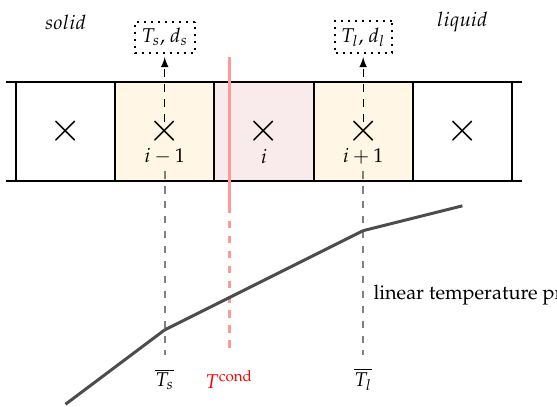
Figure 4. One dimensional example of T cond calculation — The mixed red cell is split by the red interface — Orange cells are the pure cells in the vicinity with their own temperatures T s , T l and distances to the interface d s , d l – T l , T s are averaged temperatures in the liquid or solid phases, and the goal is to compute T cond . (In 1D T s = T s (and T l = T l